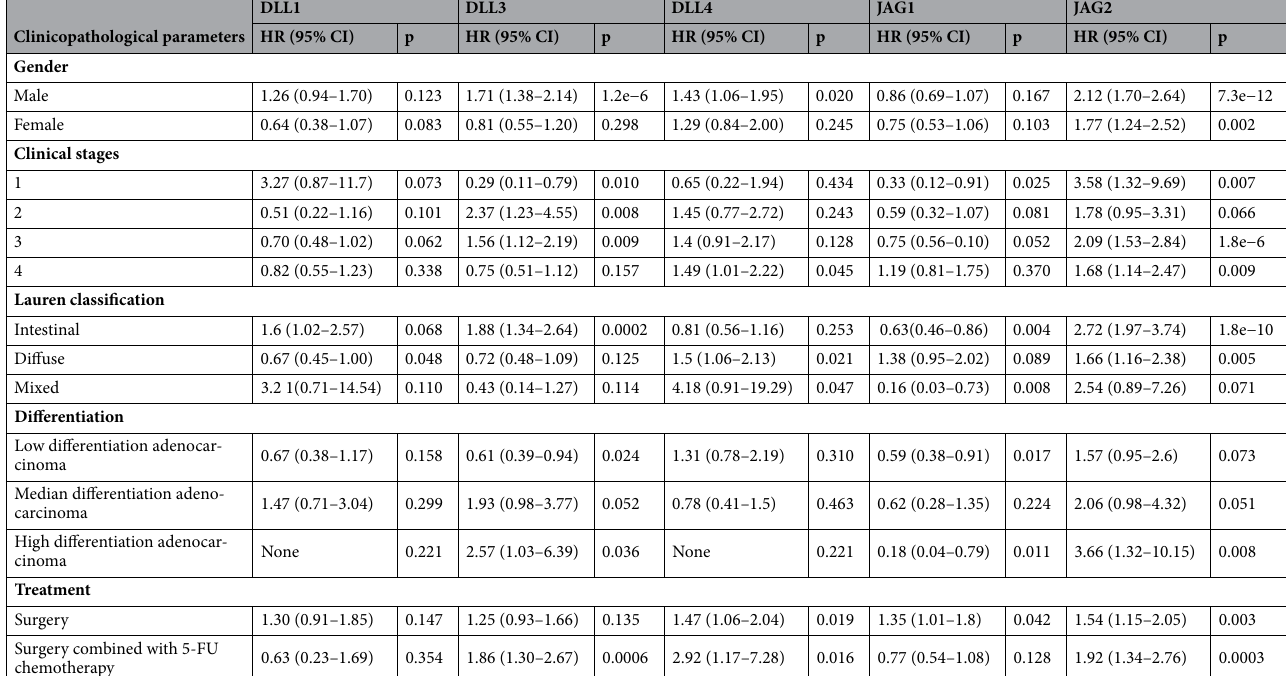
Table 1. Correlation of Notch ligands with OS of GC patients by different clinicopathological